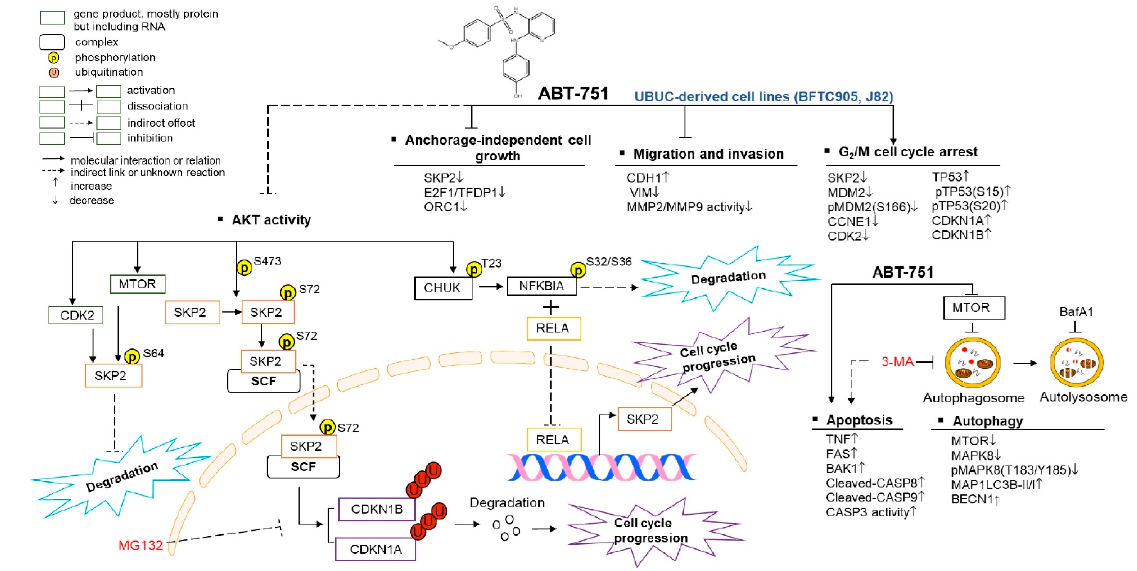
Figure 6. Summary of this study.